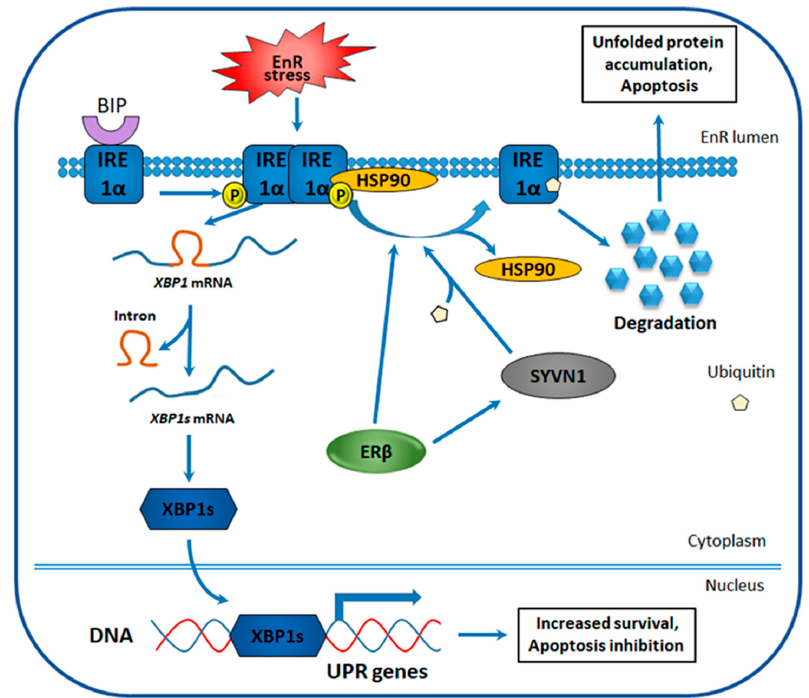
Figure 4. Proposed mechanism of ER β‐ mediated regulation of unfolded protein response (UPR) in TNBC. Endoplasmic reticulum (EnR) stress activates inositol ‐ requiring enzyme 1 α (IRE1 α ), IRE1 α TNBC. Endoplasmic reticulum (EnR) stress activates inositol-requiring enzyme 1 α (IRE1 α ), IRE1 self ‐ dimerizes and undergoes autophosphorylation, then IRE1 α induces X ‐ box ‐ binding protein 1